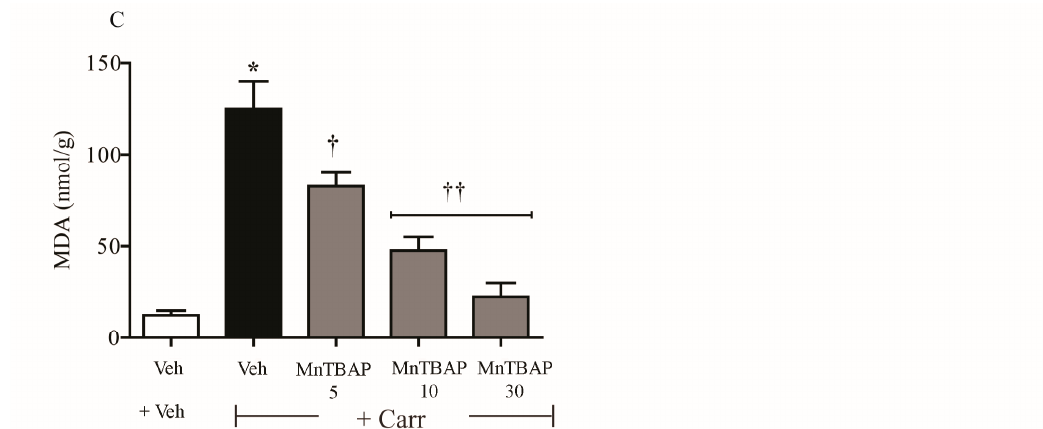
Figure 2. Intraperitoneal injection of MnTBAP in di ff erent doses (5–30 mg / kg) led to an improvement in lactate dehydrogenase (LDH) ( A ), prostaglandin E 2 (PGE 2 ) ( B ), and malondialdehyde (MDA) ( C ) levels in paw exudates, observed following the intraplantar injection of carrageenan. Results are expressed as mean ± SEM for six rats. * p < 0.01, ** p < 0.001 compared with Veh + Veh; † p < 0.01, †† p < 0.001 compared with Veh +